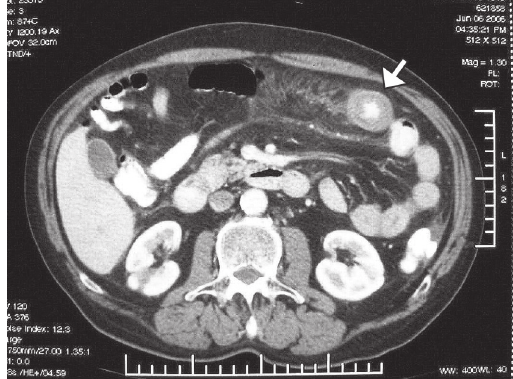
Figure 2 – Contrast CT with transverse slice showing circumferential thickening of the jejunum, known as the “pseudo-kidney” sign (arrow).